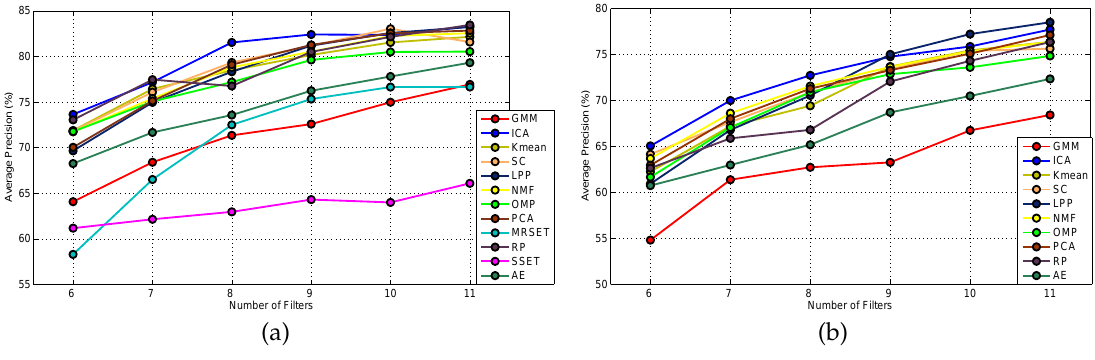
Figure 9. Classification results on two datasets with different learned linear filters. The MRSET and SSET denote the set of maximum response (MR) filters and the Schmid (S) filters, respectively, both of which are hand-designed filters and were originally designed for texture classification task. Here, we not only compare the filters learned by different unsupervised algorithms, but also compare the learned filters with the hand-designed filters in the FBC framework. ( a ) Classification accuracies on the UCM dataset; ( b ) classification accuracies on the WHU-RS dataset.